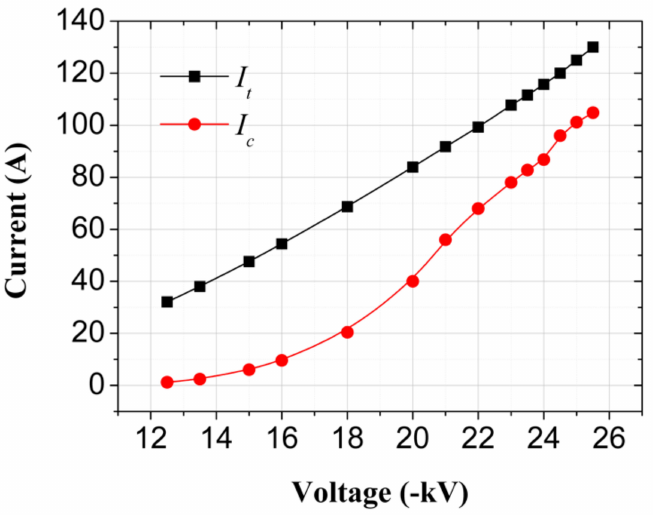
increase of the cathode voltage. The collector current I c is small and rises slowly when the voltage is less than 18 kV, but it increases fast after that. An optimal transport efficiency over 81% was obtained at a voltage of − 25 kV, which is slightly higher than the design value of − 24.5 kV. The corresponding total current and collector current are 125 and 102 mA, respectively.